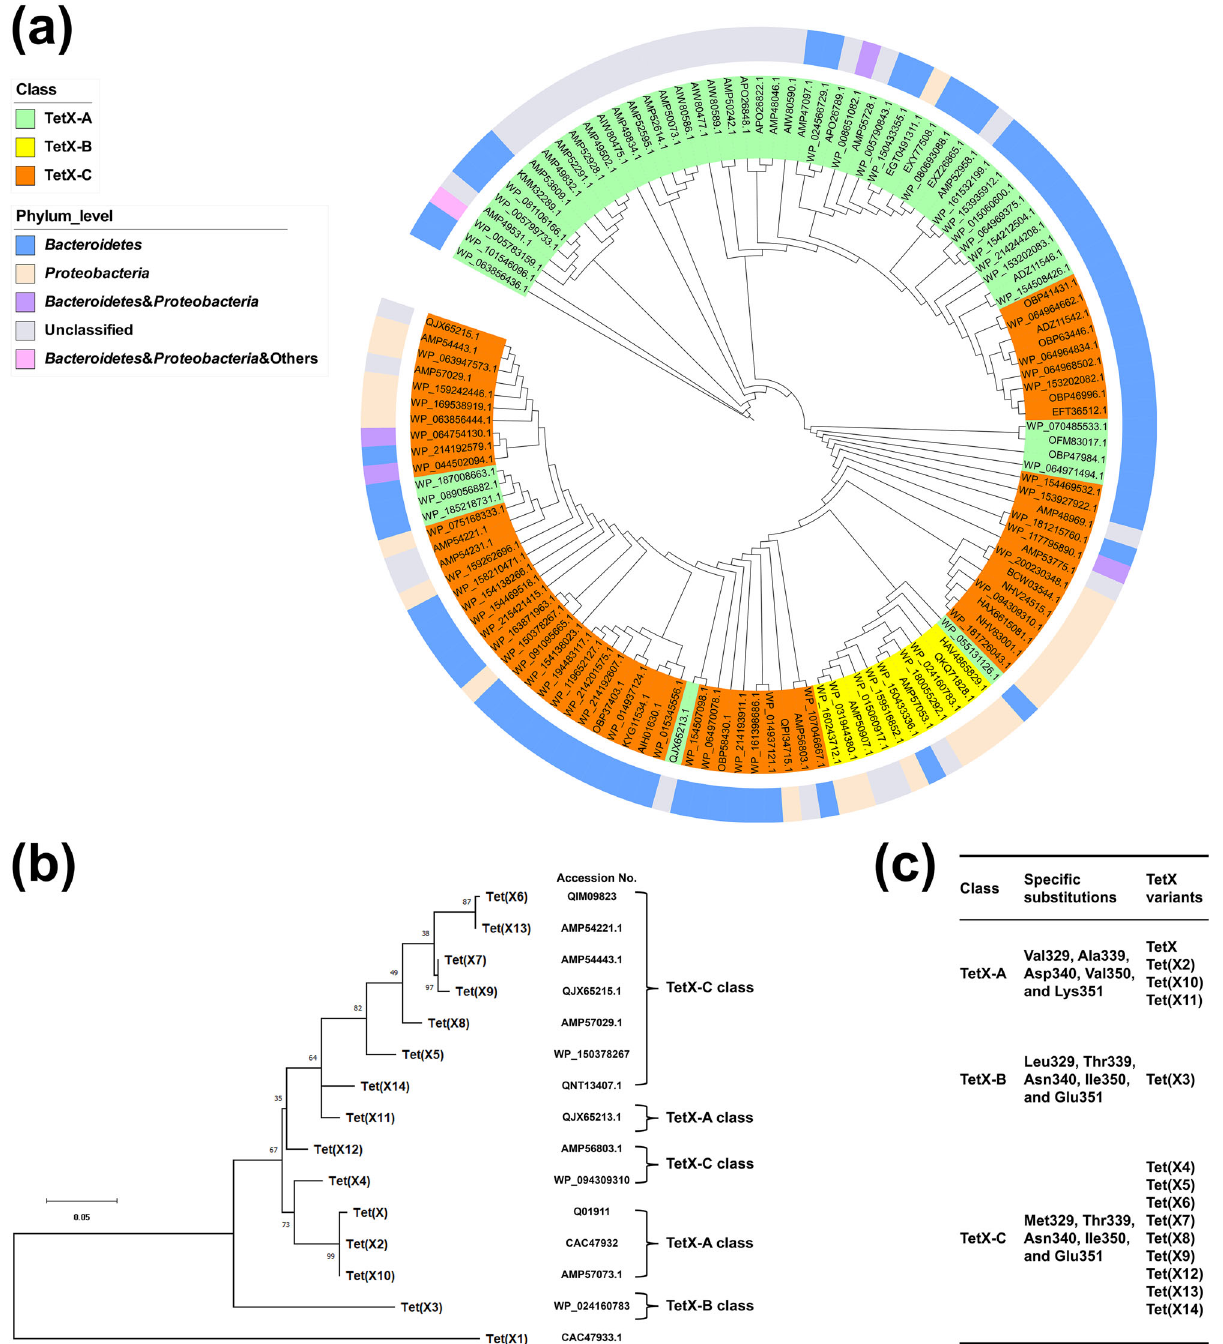
Fig. 3 Phylogenetic analysis of TetX like protein. a TetX-related proteins are divided into three classes: TetX-A (green), TetX-B (yellow), and TetX-C (orange). Phylogeny is inferred by using the maximum-likelihood method and Flu + G + I model. A discrete Gamma distribution approach was used to depict the difference in evolutionary rate among the sites [4 categories (Gamma shape parameter = 0.609)]. This analysis involved 128 amino acid sequences. Different species hits the protein sequences organized in the phylum level. Bacteroidetes , Proteobacteria , Firmicutes , Spirochetes , Bacteroidetes plus Proteobacteria , and unclassi fi ed organisms are shown in blue, pink, light purple, and gray, respectively. Evolutionary analyses were conducted in online PlyML 3.0. The tree was visualized using iTOL (ITEREACTIVE TREE OF LIFE). b Phylogenetic analysis of the amino acid sequences of the reported TetX variants. The maximum-likelihood tree was inferred using MEGA X 35 . The tree is drawn to scale, with branch lengths measured in the number of substitutions per site. c Reported TetX variants are distributed in TetX-A class, TetX-B class, and TetX-C class with speci fi c